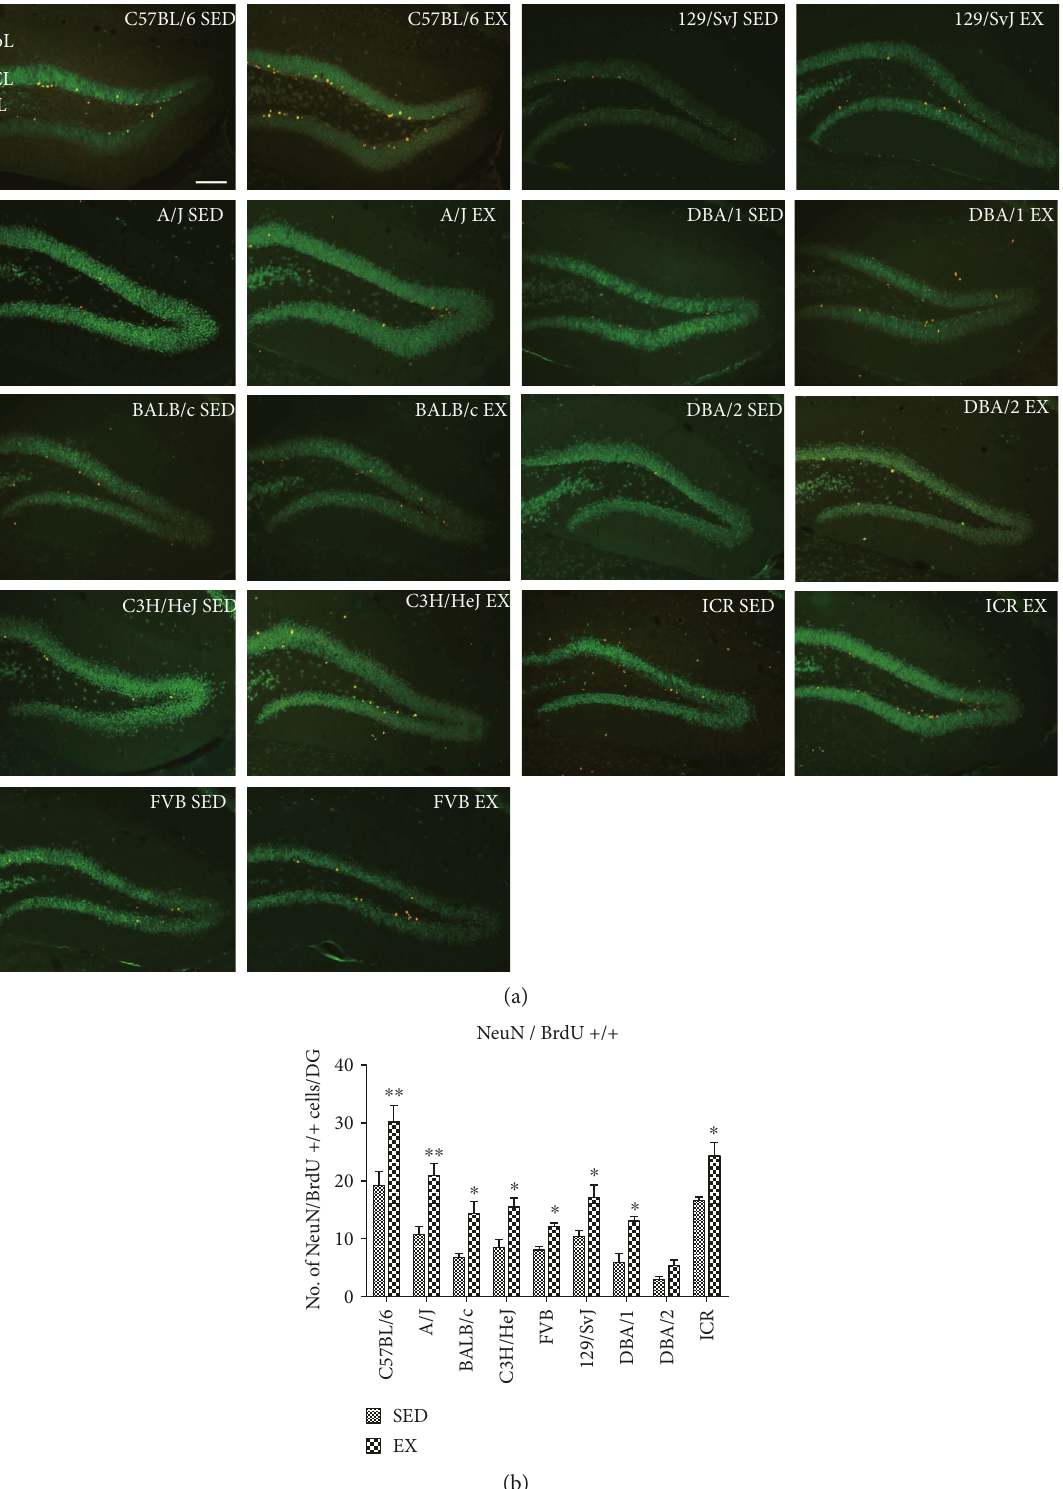
Figure 5: Double immuno fl uorescence staining for BrdU (red) and NeuN (green) in the dentate gyrus of sedentary and exercise mice of 9 di ff erent strains (a). GCL, granule cell layer; ML, molecular layer; PoL, polymorphic layer. Scale bar =100 μ m. Quantitative analysis of BrdU and NeuN double-labeled cells per section in sedentary and exercise mice (a) ( n = 5 per group); quantitative cell number of BrdU (red) and NeuN (green) double-positive cells (b); ∗ indicates a signi fi cant di ff erence between the sedentary and exercise groups ( p < 0 05 ), and ∗∗ indicates a signi fi cant di ff erence between the sedentary and exercise groups ( p < 0 01 ). Data are shown as mean ±